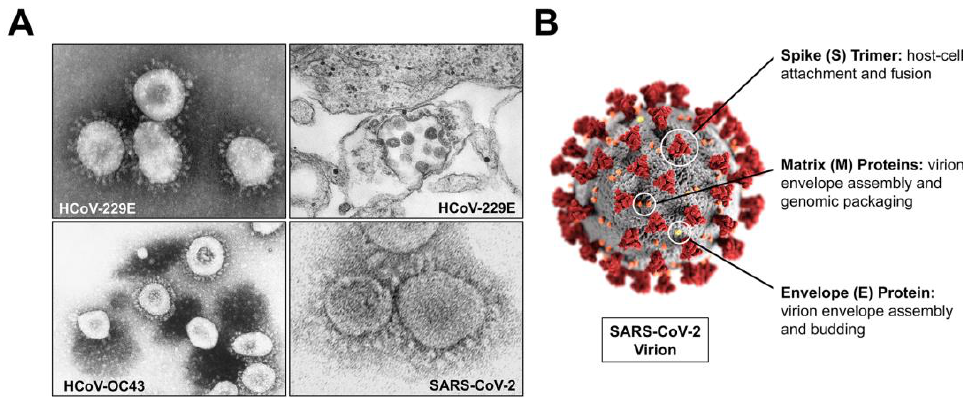
Figure 1. Coronavirus Structure. ( A ) Electron micrographs of HCoV-229E, HCoV-OC43, and SARS-CoV-2. ( B ) Coronavirus virion schematic of SARS-CoV-2 with labeled structural proteins and their respective functions. All images were adapted from the Centers for Disease Control and Prevention (CDC) via the Public Health Image Library (PHIL).